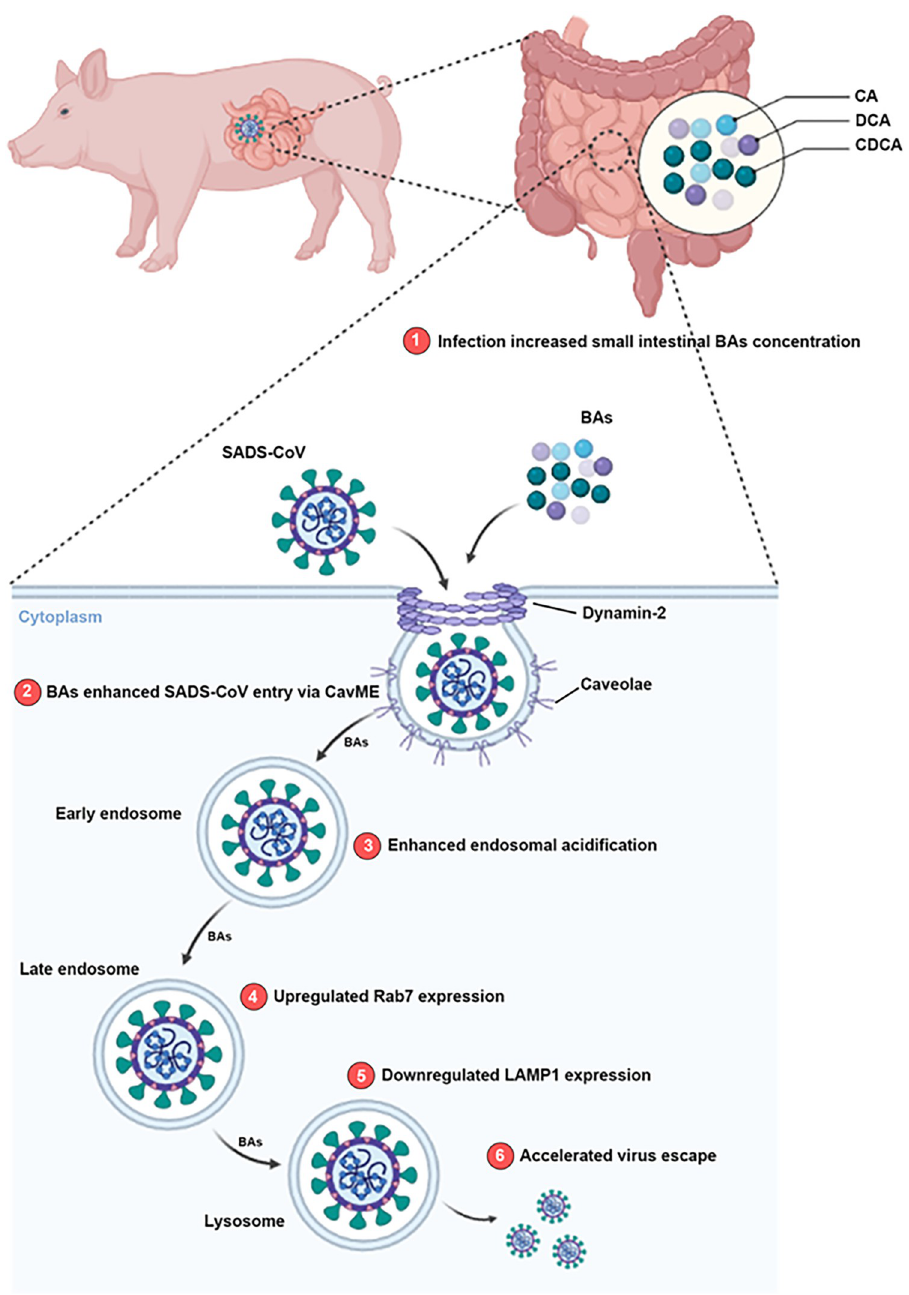
Fig 9. Proposed model for SADS-CoV infection in porcine intestinal enteroids (PIEs) enhanced by bile acids (BA). 1) SADS-CoV infection induces a significant increase of BA concentration in the small intestine of piglets, and this BA-rich microenvironment promotes SADS-CoV replication in the epithelial cells. 2) BAs enhance SADS-CoV entry via CavME, and dynamin-2 is required for this effect. In the presence of BAs, 3) endosomal acidification is increased; 4) Rab7 expression is upregulated and 5) LAMP1 expression is downregulated. These cellular changes induced by BAs might alter the dynamics of endosomal/lysosomal system and 6) aid SADS-CoV escape into the cytoplasm. The image was created using the website https://app.biorender.com/.